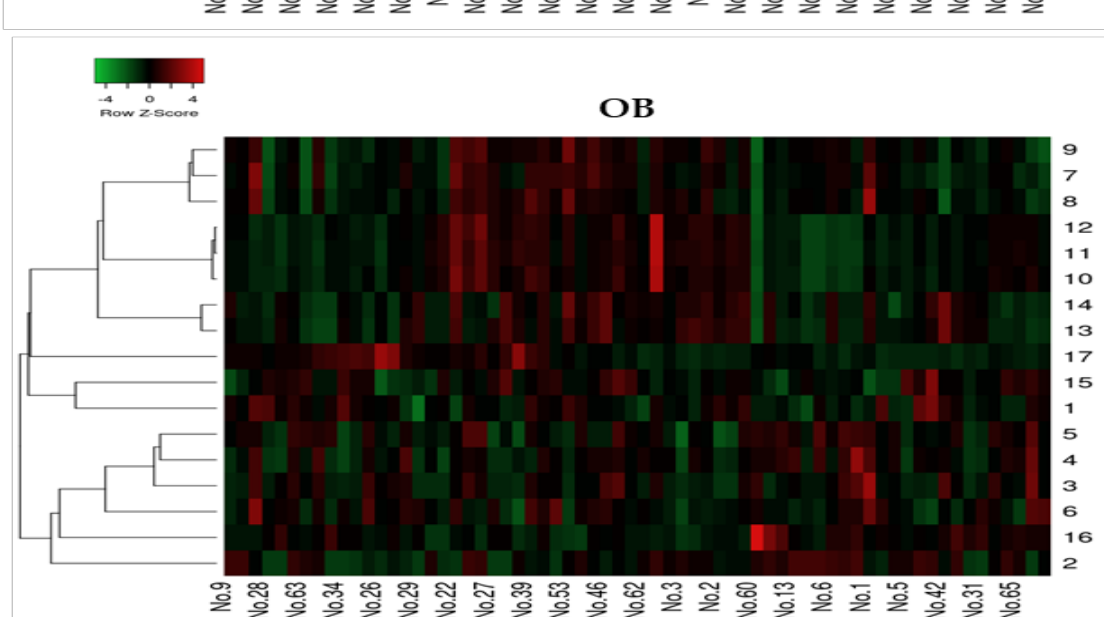
Figure 2. Heatmap of raw data (normalized to mean or median) and correlation of all the outcomes in the overall, NW, and OB groups. The colour red and green are representing the negative and positive correlations, respectively. Symbols: NW, normal weight; OB, obesity; Blood leukocyte relative telomere length = 1; age = 2; body mass index = 3; waist circumference = 4; body fat (%) = 5; fat-free mass = 6; RMR AB , absolute resting metabolic rate = 7; RMR BM , resting metabolic rate adjusted for body mass = 8; RMR FFM , resting metabolic rate adjusted for FFM = 9; RFO AB , absolute resting fat oxidation rate = 10; RFO BM , resting fat oxidation rate adjusted for body mass = 11; RFO FFM , resting fat oxidation rate adjusted for fat-free mass = 12; V ̇ O (mL/kg BM/min), maximum oxygen consumption 2max adjusted for body mass = 13; V ̇ O (mL/kg FFM/min), maximum oxygen consumption 2max adjusted for fat-free mass = 14; MDA, malondialdehyde = 16; hsCRP, high-sensitivity C- reactive protein = 17.